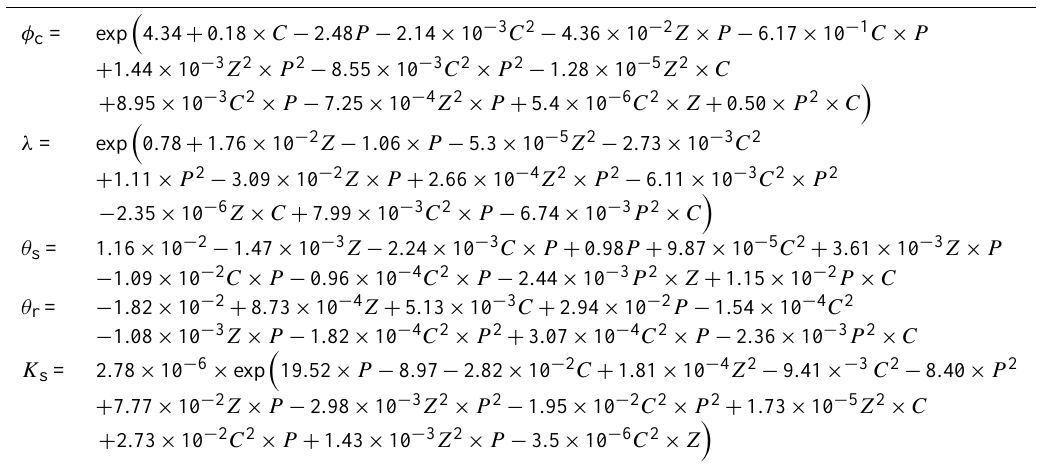
Table 1. Regression equations of the Rawls and Brakensiek (1985, 1989) pedotransfer functions to estimate the soil hydraulic parameters from the Brooks and Corey (1964) hydraulic